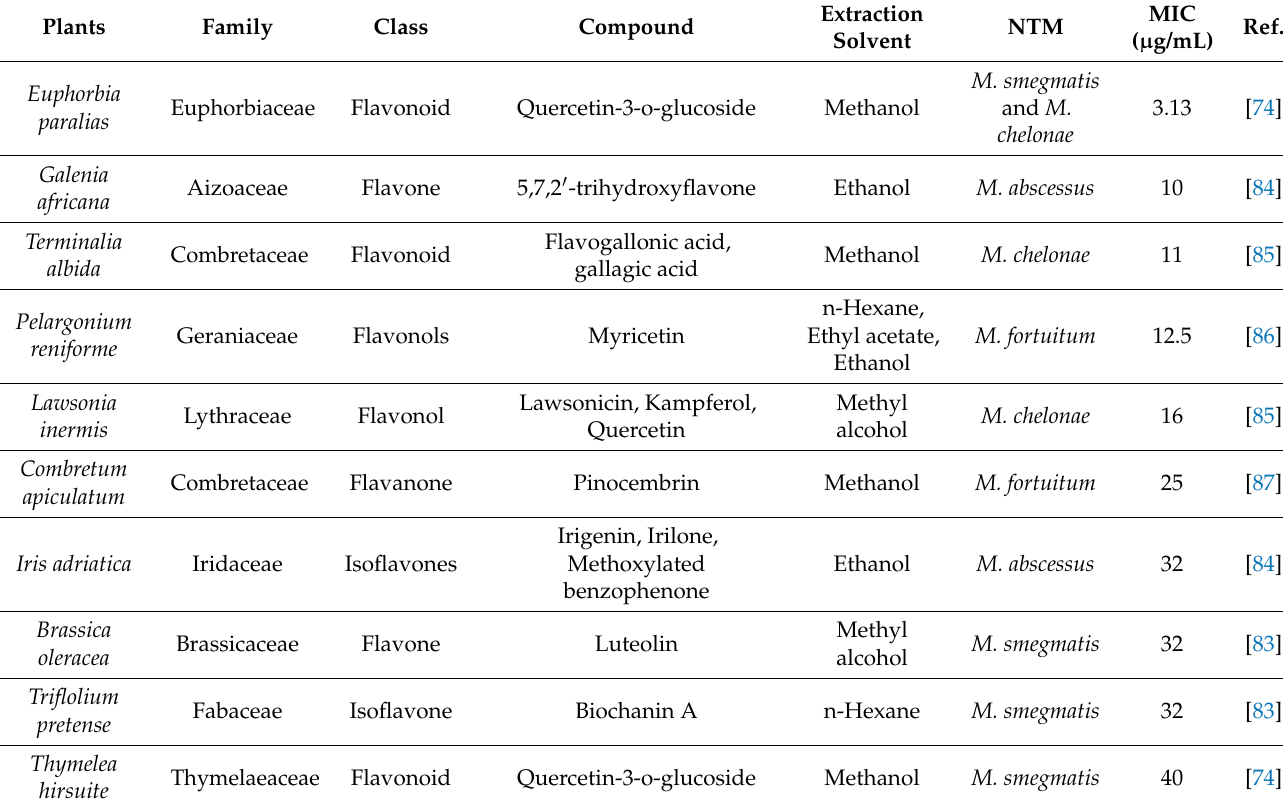
Table 3. List of anti-NTM flavonoids extracted from various